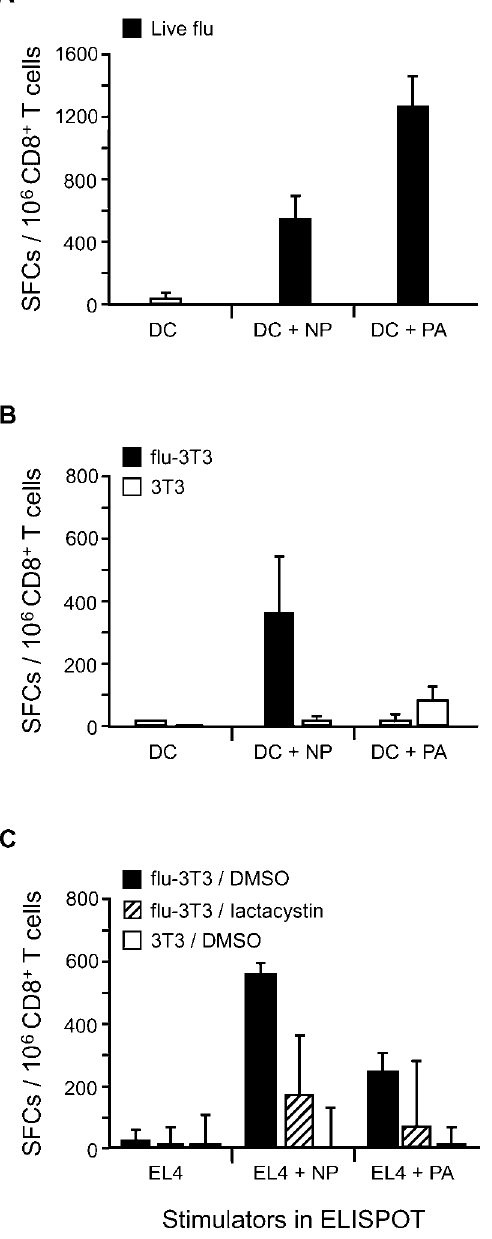
Figure 4. Immunization with Apoptotic Cells Results in the Selective Priming of T Cells Reactive to Processed Antigen (A and B) C57BL/6 mice were immunized intraperitoneally with 300 HAU of influenza (A), or 5 3 10 6 infected apoptotic 3T3 cells (B). After 14 d, splenocytes were harvested, and CD8 þ T cells were purified. To assay for the specificity of these cells, an IFN- c ELISPOT was performed using the following stimulators: DCs alone or DCs pulsed with either 1 l M NP 366–374 or 1 l M PA 224–233 peptide. (C) C57BL/6 mice were immunized intraperitoneally with 5 3 10 6 untreated versus lactacystin-treated influenza-infected apoptotic 3T3 cells. As above, 14 d after priming, splenocytes were harvested, and CD8 þ T cells were purified and assayed for their reactivity to NP 366–374 versus PA 224–233 . In this experiment, peptide-pulsed EL4 cells were employed as the stimulators. Data are representative of two experiments. Values are averages of triplicate wells with error bars indicating standard